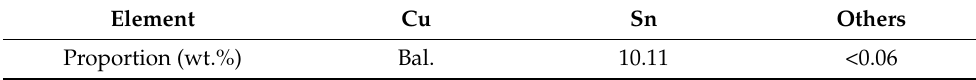
Table 3. Chemical composition of CuSn10 powder.